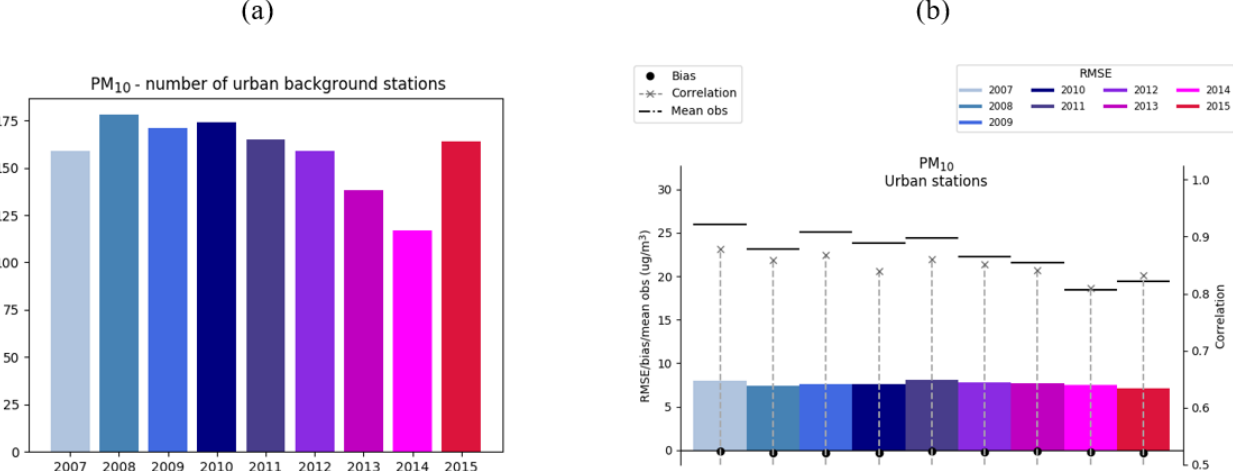
Figure 2. PM 10 : statistical indicators calculated using cross-validation technique on daily mean PM 10 values measured and estimated over URBAN background stations for the years 2007 to 2015. (a) Number of rural stations for each year. (b) Bias (black circles), RMSE (colored rectangles), correlation (grey crosses and the associated dashed lines) and mean observation (horizontal